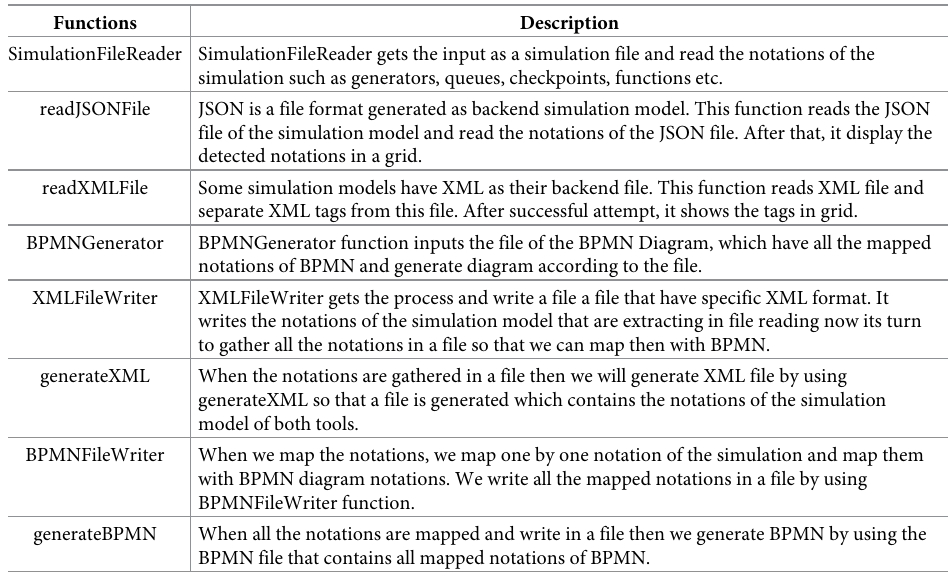
Table 3. List of java function with its